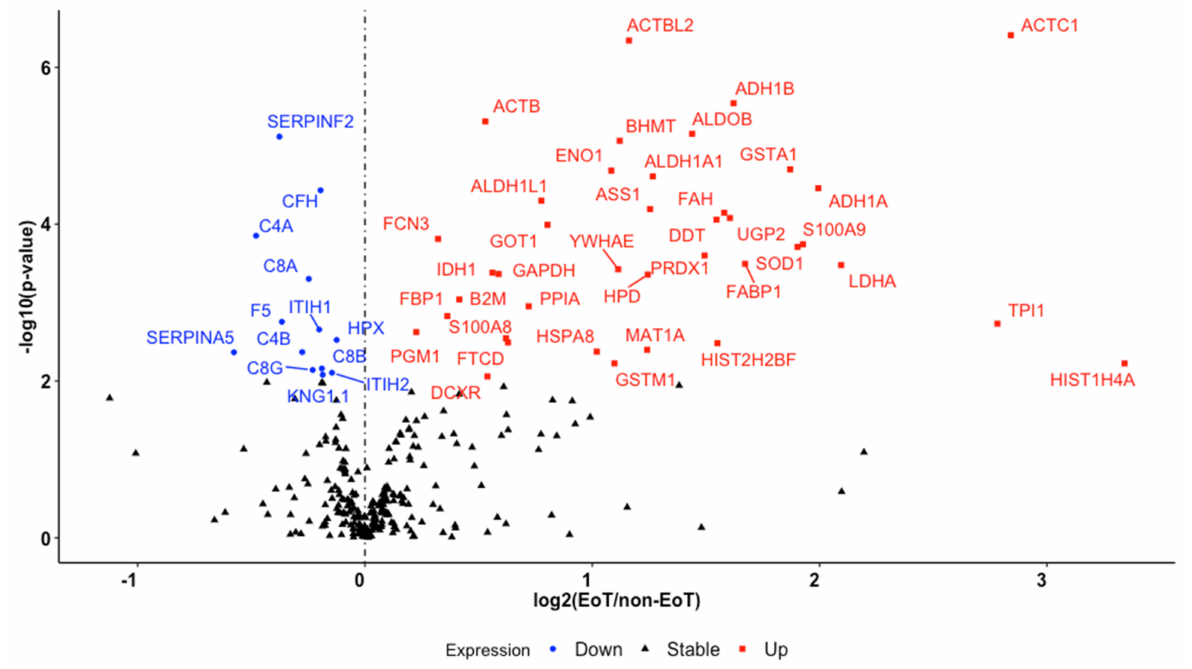
Figure 1. Volcano plot featuring differentially expressed proteins between the EoT and non-EoT group. EoT: endotheliopathy of trauma defined by plasma syndecan-1 ≥ 40 ng/mL; p -value: Benjamini and Hochberg false discovery rate-adjusted p -value; labeled proteins represent an adjusted p -value <